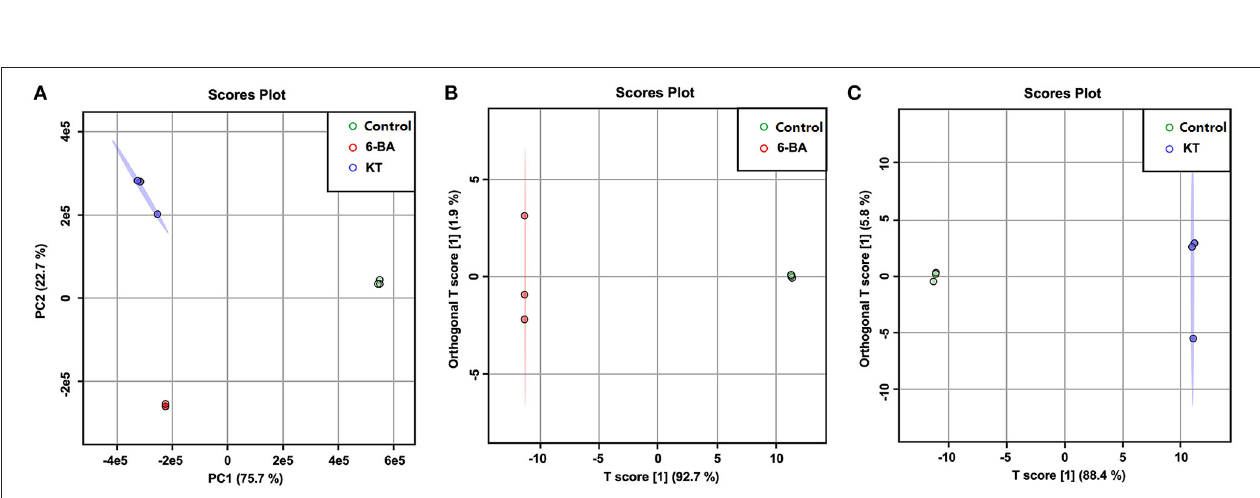
FIGURE 2 | Score plots of models. (A) PCA score plots of control, 6-BA, and KT groups. (B) OPLS-DA score plots of control and 6-BA group. (C) OPLS-DA score plots of control and KT group.